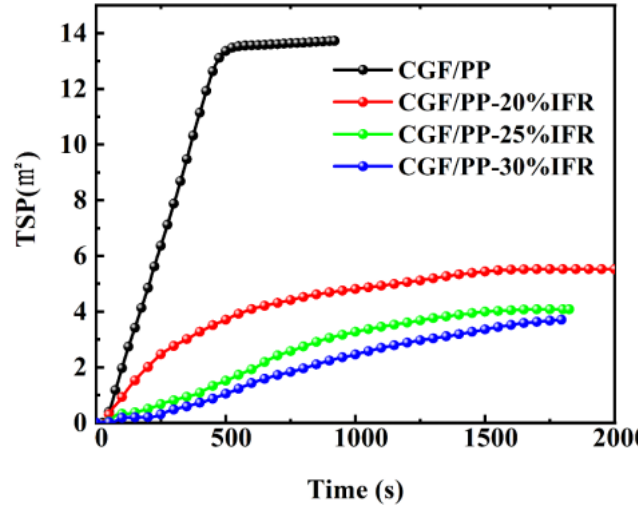
Figure 8. Total smoke production rate curves of composites with different IFR content.